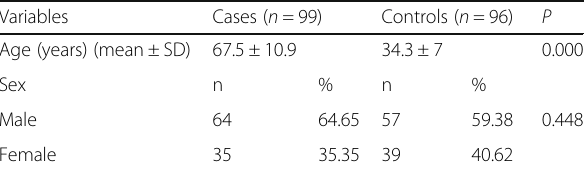
Table 1 Demographic characteristics of the cases and